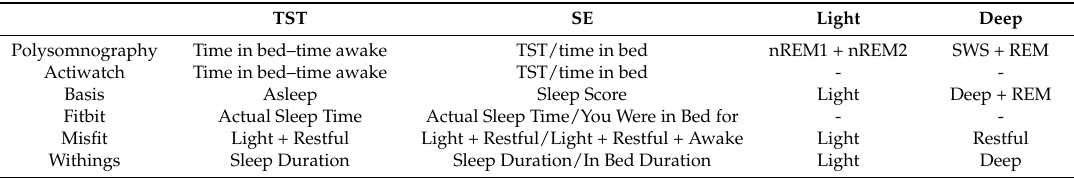
Table 1. Measures compared across